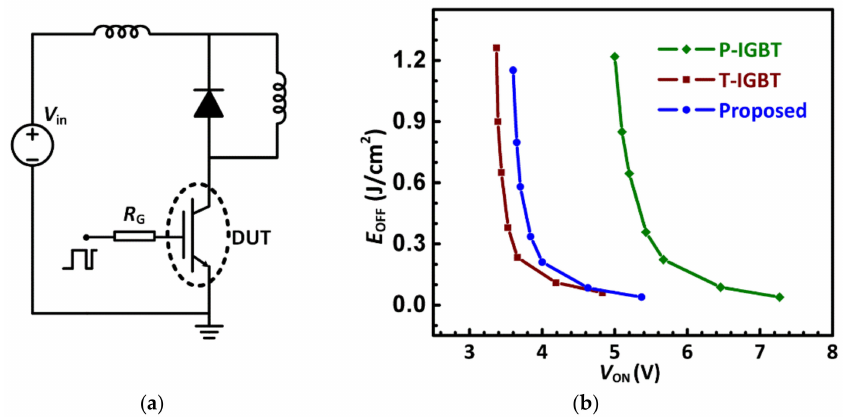
Figure 8. ( a ) Schematic of the circuit for simulating switching characteristics. ( b ) E OFF - V ON trade-off characteristics of the studied P-IGBT, T-IGBT, and proposed IGBT with changing the doping density of the p-collector